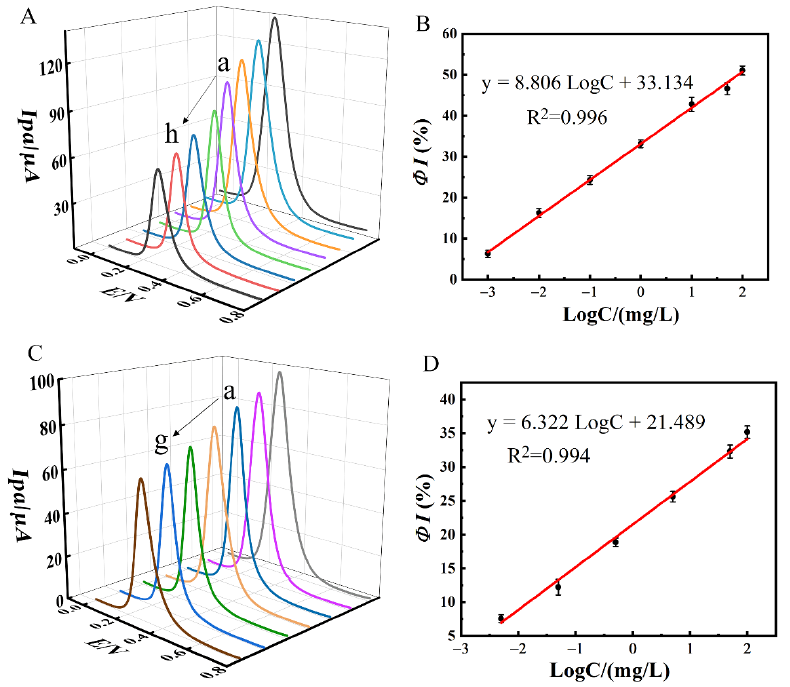
Figure 10. ( A ) DPV responses of MCH/Apt/AuNPs/NiHCF-NPs/Zn/Fe-ZIF-NPC/GCE in 0.1 M PBS at pH 7.0 after incubation with different concentrations of PQ (from a to h: 0, 0.001, 0.01, 0.1, 1.0, 10, 50, 100 mg/L), ( B ) the calibration curve for PQ detecting on MCH/Apt/AuNPs/NiHCF-NPs/Zn/Fe- ZIF-NPC/GCE. ( C ) DPV responses of MCH/Apt/AuNPs/NiHCF-NPs/GCE after incubation with different concentrations of PQ (from a to g: 0, 0.005, 0.05, 0.5, 5.0, 50, 100 mg/L), ( D ) the calibration curve for PQ detecting on MCH/Apt/AuNPs/NiHCF-NPs/GCE. Error bars were obtained as the standard deviation of triple measurements ( n = 3).